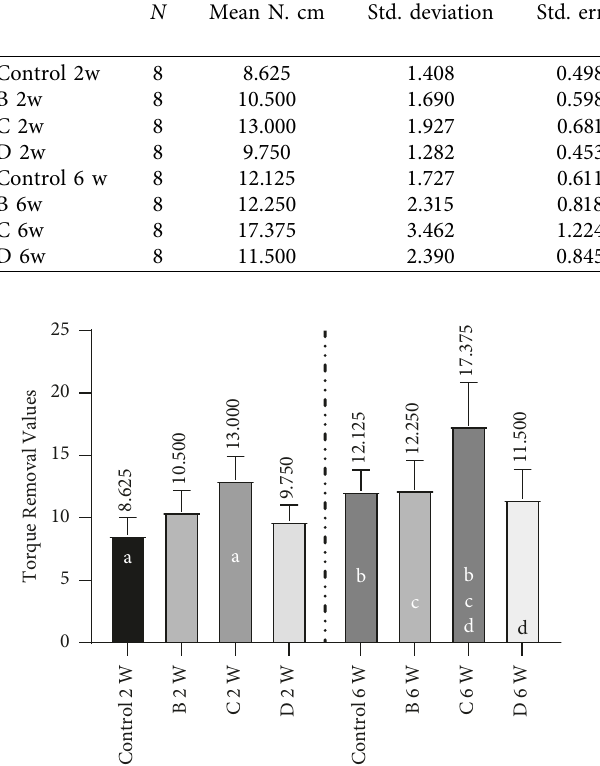
Table 1: Descriptive statistical analysis for the torque removal test after 2 to 6 weeks of the healing period. N Mean N. cm